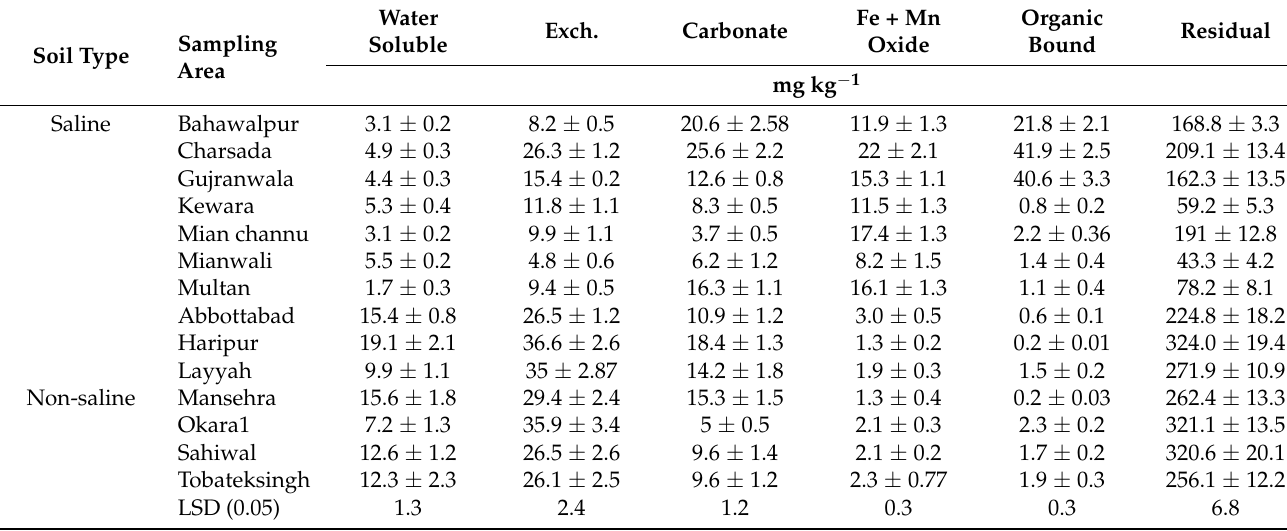
Table 6. Fractionation of Zn in saline and non-saline soils.